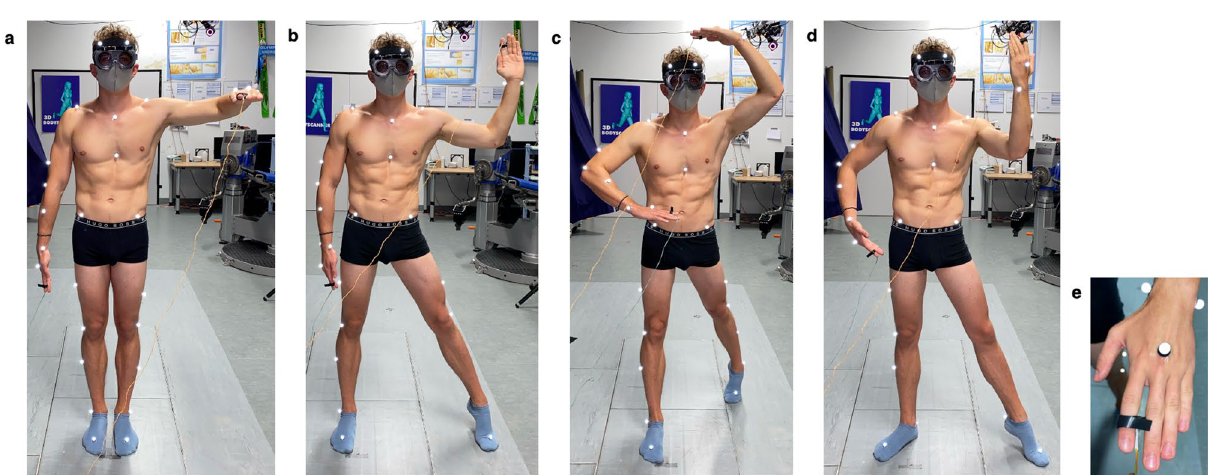
Figure 5. Taking-a-pasture task: four poses of different complexity (change in numbers of limbs involved) with Vicon full-body plugin-gait marker set and goggles to restrict vision of own body. ( a ) One upper extremity (non-dominant); ( b ) one upper and one lower extremity (both non-dominant); ( c ) two upper extremities and one lower extremity (non-dominant: arm above head); ( d ) all extremities explicitly involved in posture (non- dominant: arm facing head, foot extended); ( e ) button